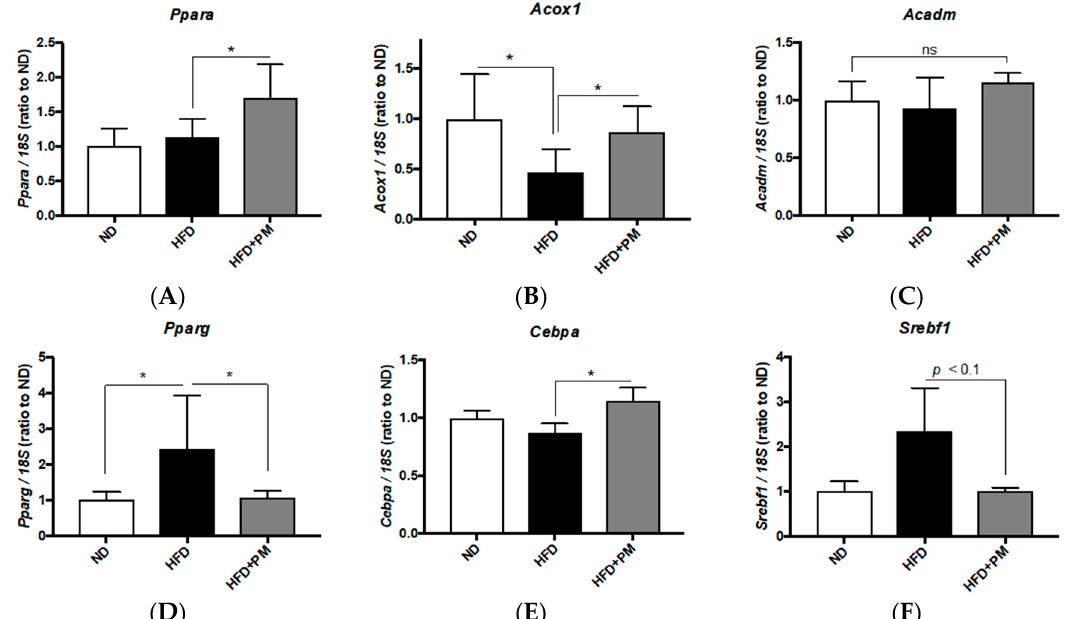
Figure 5. PM ‐ induced gene expression changes in liver tissues of mice. ( A – C ) PM effects on gene expression related to beta ‐ oxidation in mice. PM upregulated Ppara ( A ) and Acox1 ( B ) expression, as seen with zebrafish (Figure 4A,B). Acadm ( C ) expression was not affected by PM. * p < 0.05. n = 6. ( D – F ) PM effects on gene expression related to lipogenesis in zebrafish. PM suppressed HFD ‐ induced upregulation of Pparg ( D ), with increase of Cebpa expression ( E ). Srebf1 was slightly ( p < 0.1) downregulated by PM ( F ). * p < 0.05. n = 6, error bars indicate SD. ns indicates no significant difference.